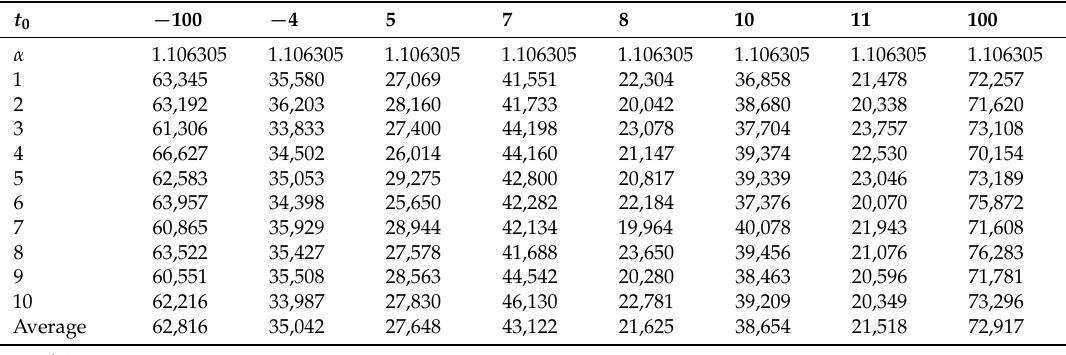
Table 8. Running time for different initial values of Example 4 by our method.